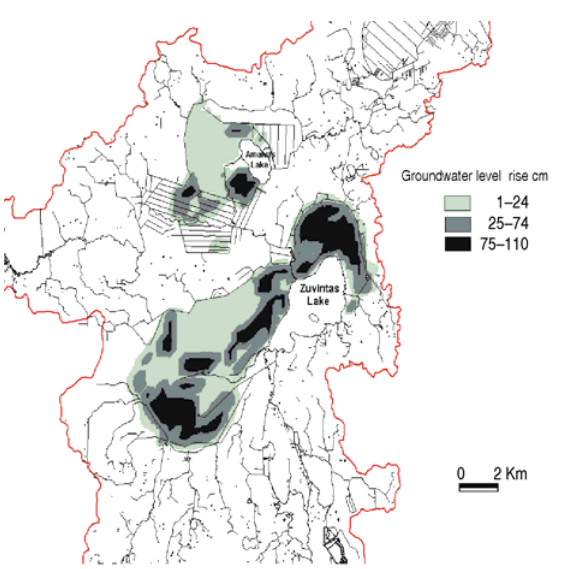
Fig. 4. Land cover in the Žuvintas and Amalvas wetlands